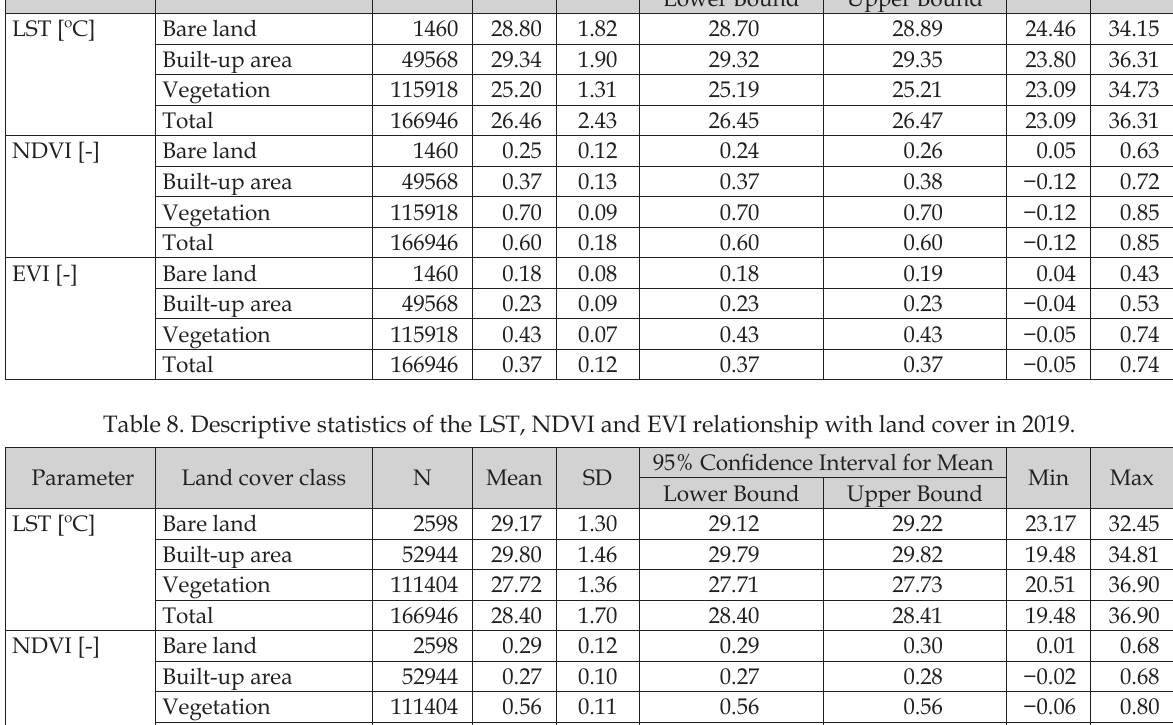
Table 7. Descriptive statistics of the LST, NDVI and EVI relationship with land cover in 2013. Parameter